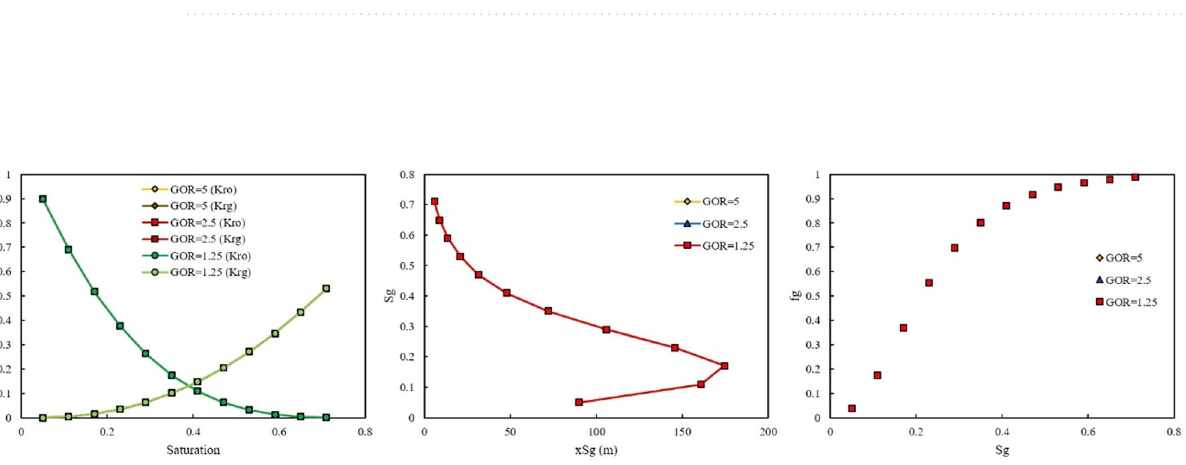
Figure 10. Effect of GOR of Naphtha on relative permeability, saturation profile, and fractional flow curve at an injection pressure of 2000 psi.